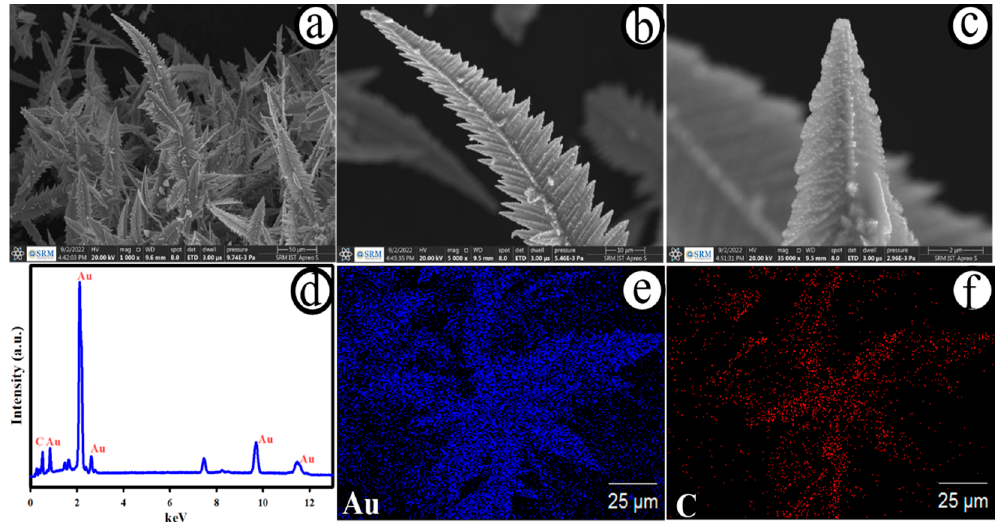
Figure 1. FE-SEM images ( a – c ), EDX spectrum ( d ) and elemental mapping ( e , f ) of the AuNC@AuDS|CF microelectrode.